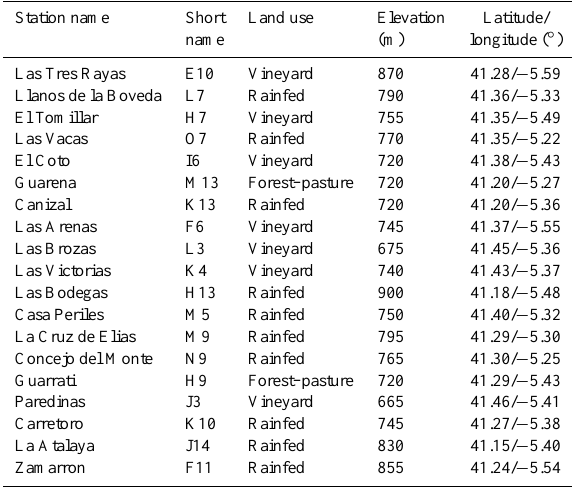
Table 1. Descriptions of the 19 soil moisture stations used in the